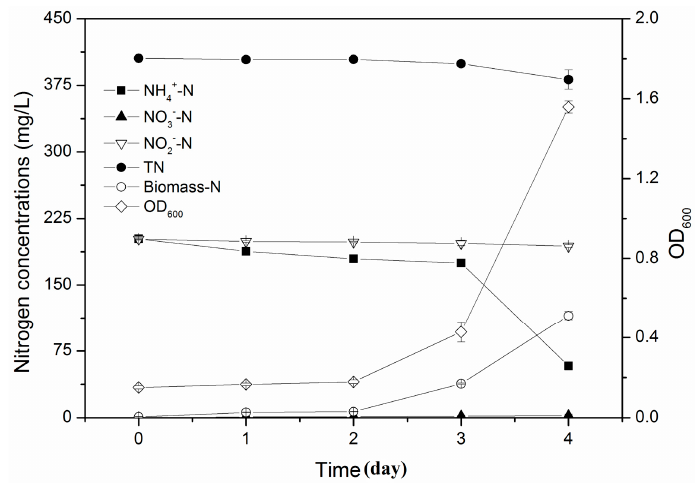
Figure 5. Simultaneous nitrification and denitrification characteristics of strain Y-12 in the presence of NH 4 + -N and NO 2 −